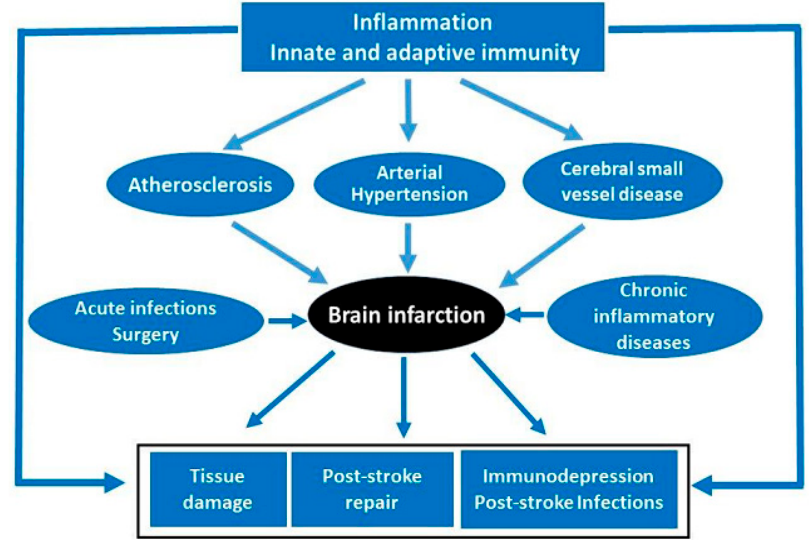
Figure 3. Inflammation and immunity events preceding and following acute ischemic stroke .